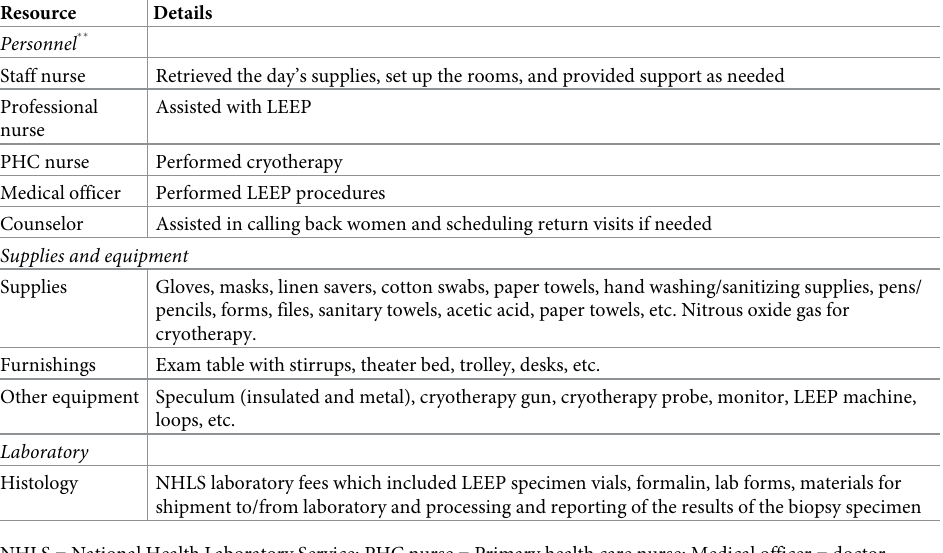
Table 2. Resources utilized to provide LEEP and cryotherapy services within an HIV care and treatment facility in Johannesburg, South Africa �